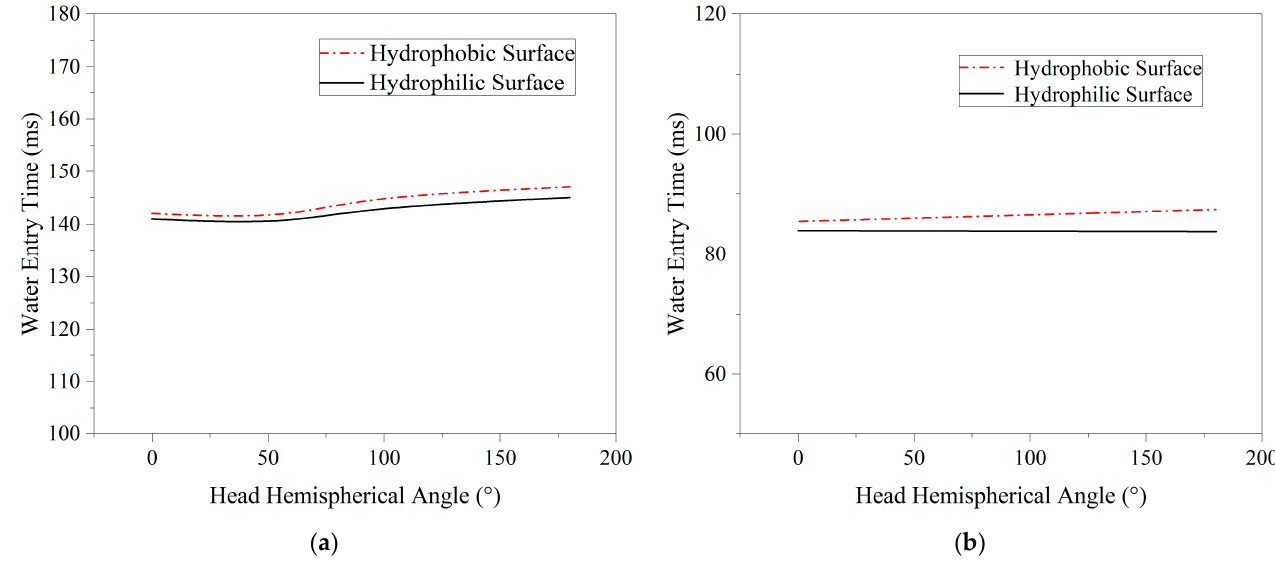
Figure 24. The total water entry times of different hemispherical angular head shape models. ( a ) The initial velocity v = 2.2 m/s. ( b ) The initial velocity v = 3.95 m/s.